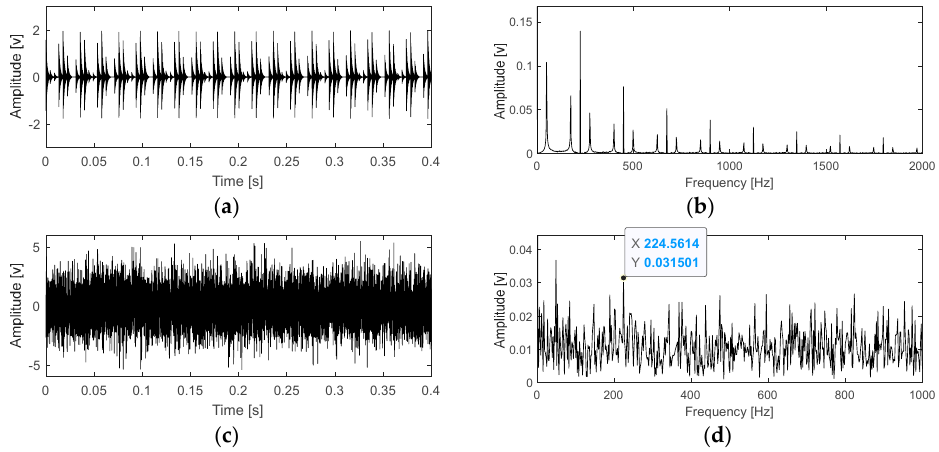
Figure 3. Simulated and noised vibration signal of faulty rolling bearing: ( a ) simulated vibraiton signal of fault bearing; ( b ) envelope spectrum of the signal as shown in ( a ); ( c ) the signal as shown in Figure 3a with added noise; ( d ) envelope spectrum of the signal as shown in ( c ).